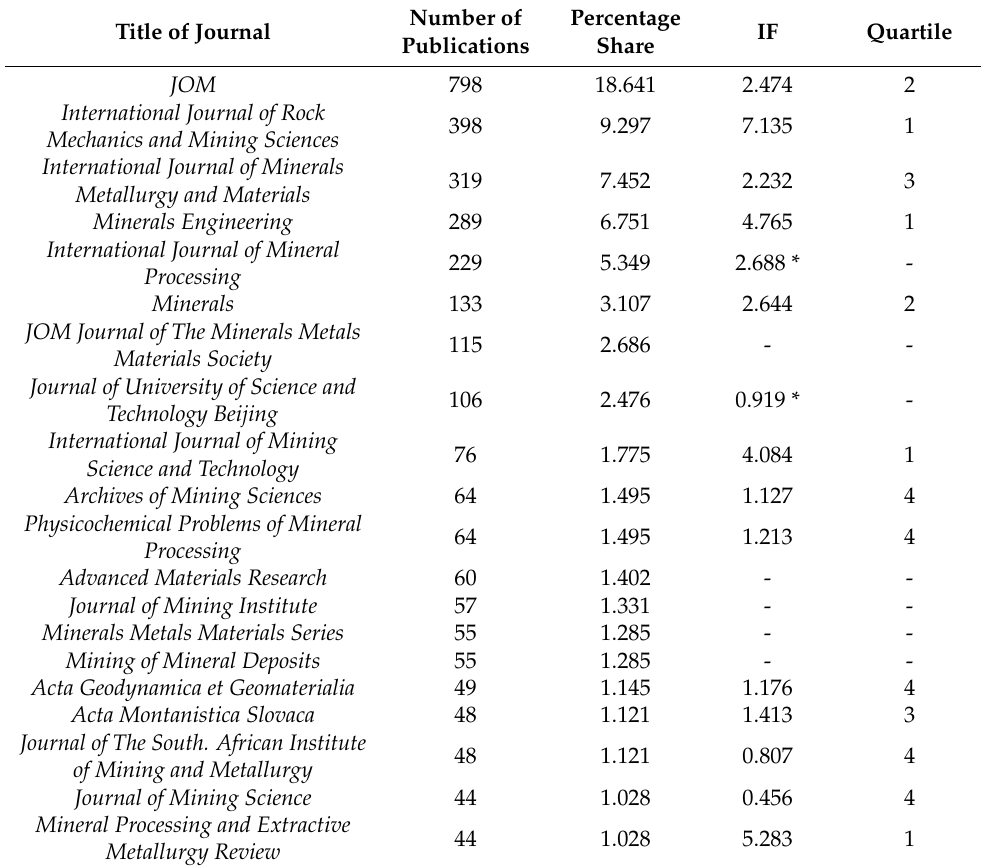
Table 3. Top 20 journals with the highest number of publications concerning mechanical processing.